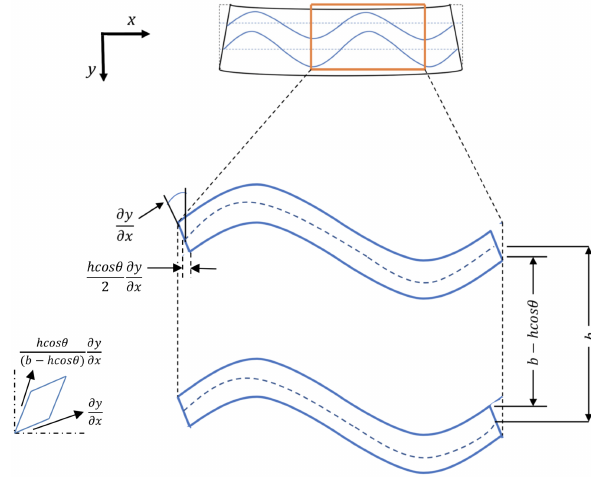
Figure 5: Deformation due to strain in the xy plane ( 𝛾 xy ) on a magni- fied section [31]